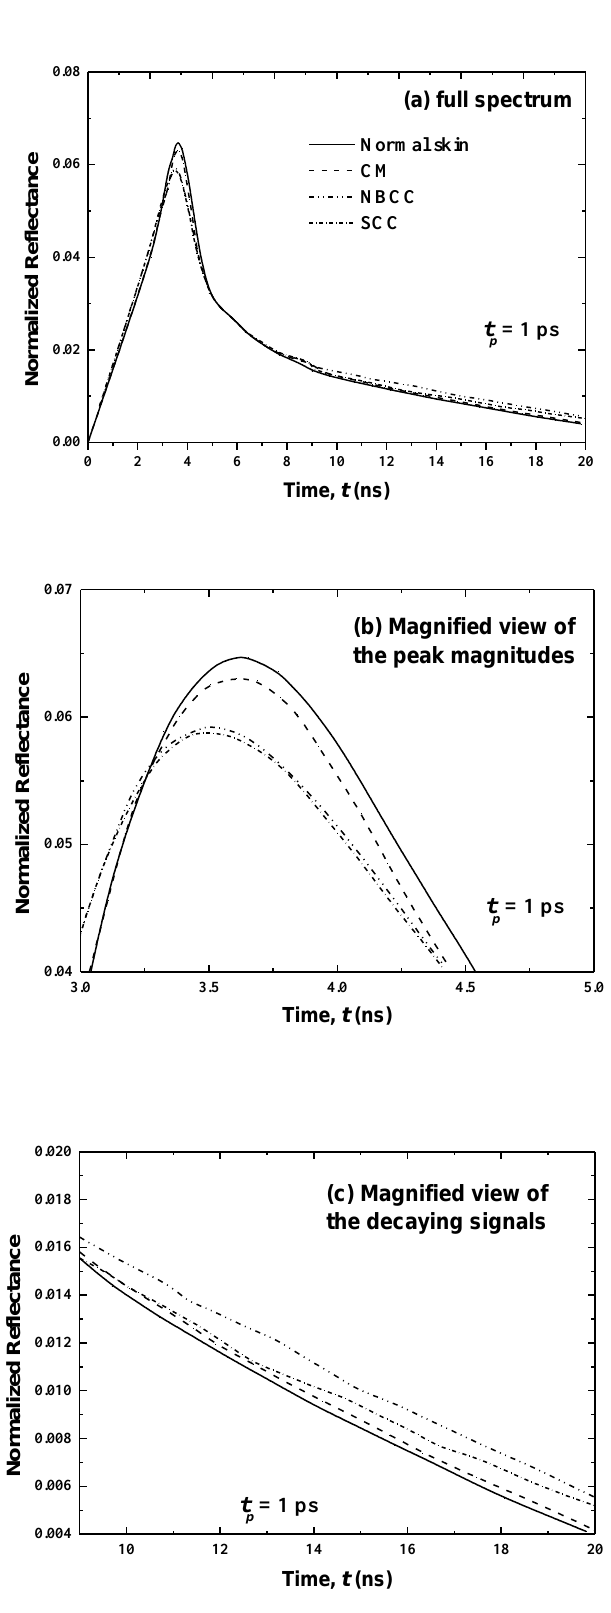
Figure 6. Temporal signals of normalized reflectance from the normal skin and skin with malignancy in the basal layer (thickness: 10 μm).